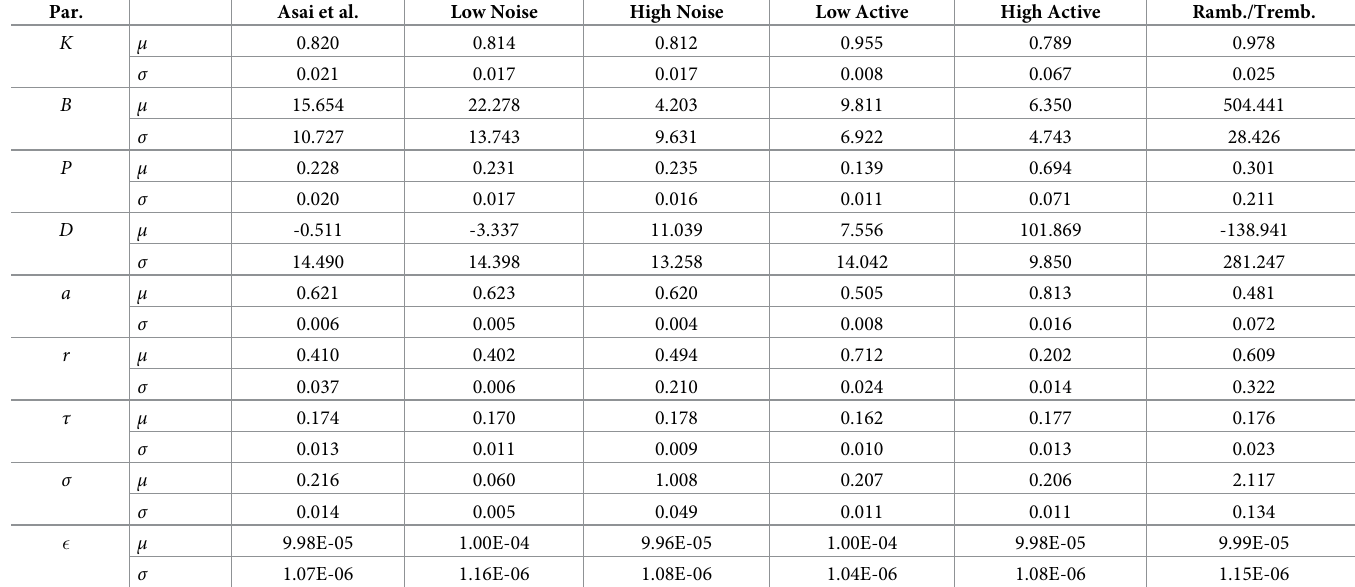
Table 5. Simulation results: Means ( μ ) and standard deviations ( σ ) of estimated parameters over 100 iterations of simulation for six parameter sets. True values are given in Table 3, and parameter descriptions are given in Table 1.